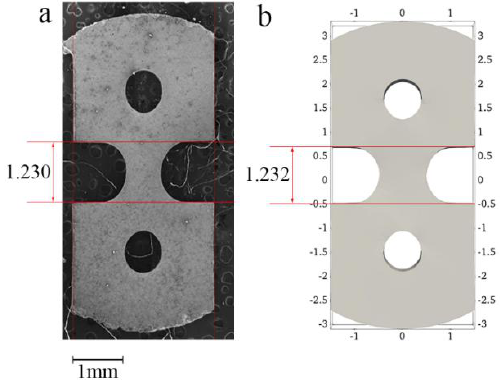
Figure 4. Specimen profile of specimen 3-1 after deformation ( a ) measured by SEM; and ( b ) derived from CP-FEM simulation (units are in mm).